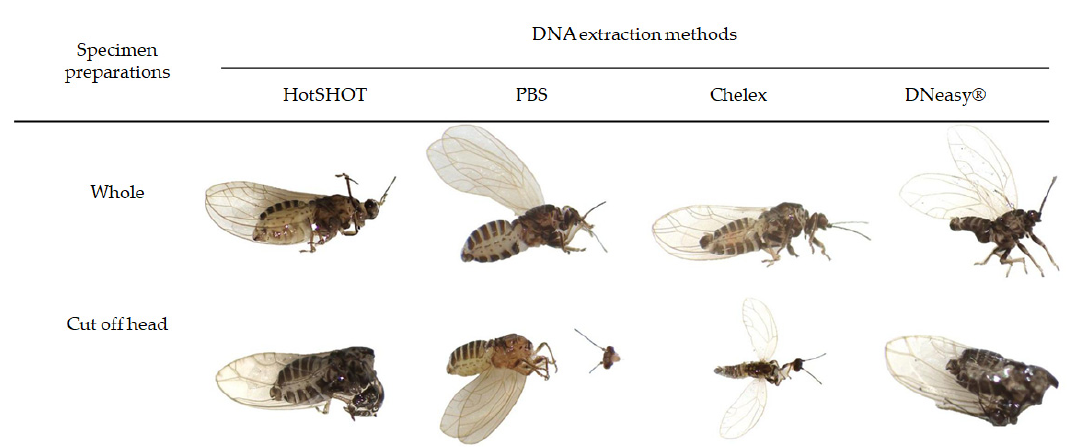
Table 8. Summary of protocol according of time consumed, cost per sample, and reagent residues generated for each of the evaluated DNA extraction